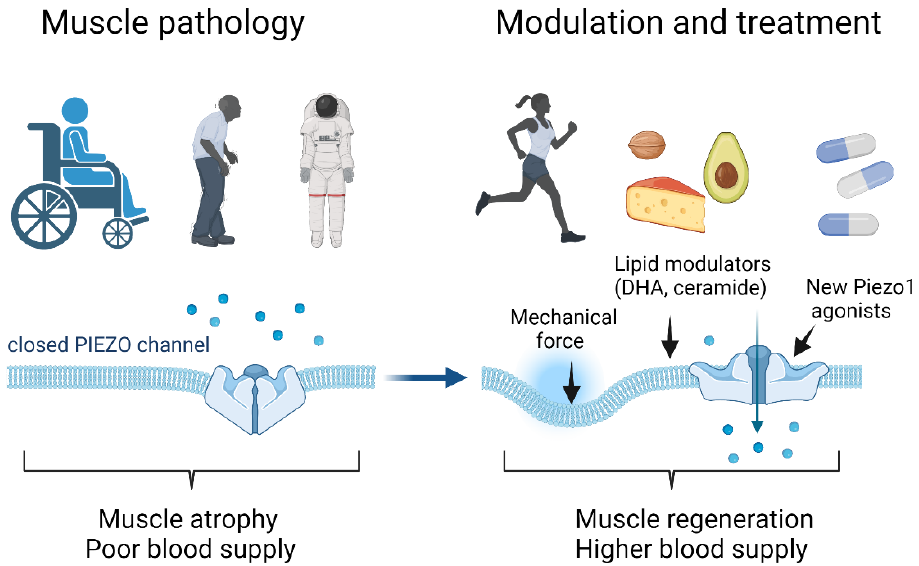
Figure 2. Potential Piezo1-based therapeutic strategies to counteract skeletal muscle impairments. Muscle disuse, aging and unloading might reduce Piezo1 activity, contributing to muscle atrophy and poor blood supply. Potentiation of Piezo 1 activity by physical exercise, diet and chemical/pharmacological activation might enhance the regenerative potential and, possibly, skeletal muscle vascularization and provide a higher blood supply. DHA and ceramide are lipids which are able to enhance the activity of Piezo1 channels, reducing their limiting inactivation state. These indirect and more direct Piezo1-based therapeutic strategies based on novel mechanisms of Piezo1 activation could thus represent promising new countermeasures versus atrophy and diseases related to muscle weaknesses (Figure created with Biorender.com, accessed on 2 May